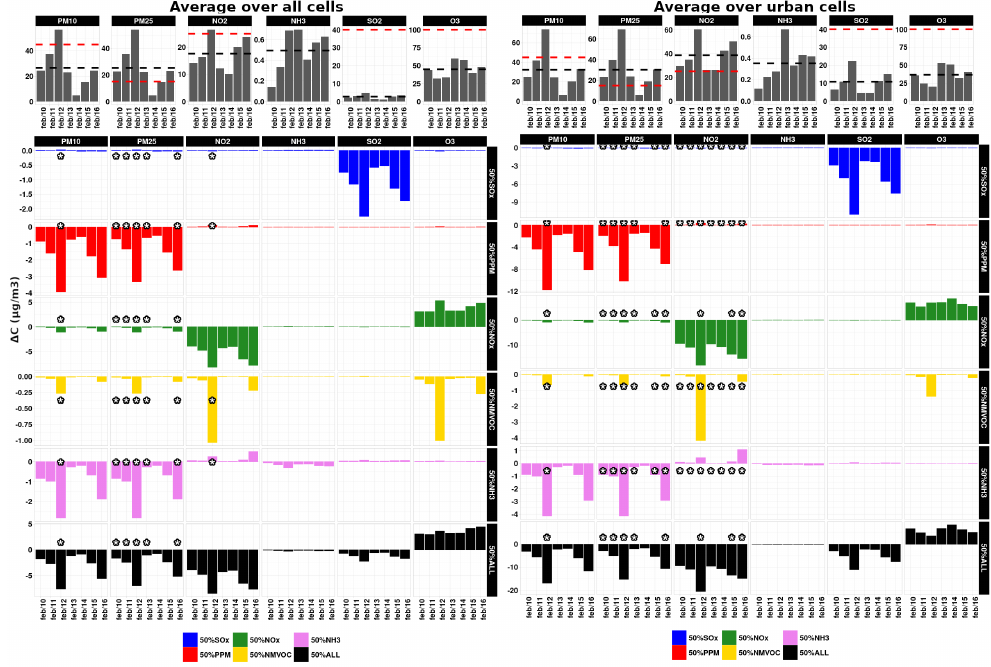
Figure 6. Daily time series between the reference simulation and each scenario. The daily average over all cells and the urban cells are shown in the left and right panels, respectively. Each column represents a specific species, while each row represents a scenario. The average value for the reference simulation is given above each panel. On top of the figure, daily averages for the reference simulation are also shown; the red dashed line showing the WHO guideline and the black dashed line showing the average in the simulations over the week. The asterisks on the scenarios represent when the daily concentration exceeds the WHO guidelines. As per WHO guidelines, maximum 8 h averages are shown for ozone for the reference